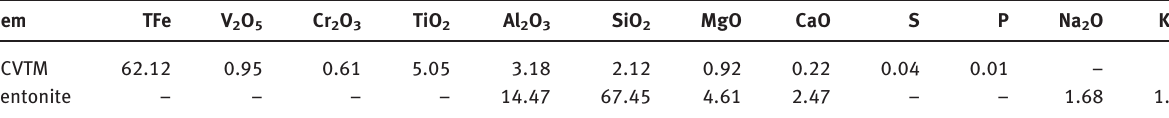
Table 1: Chemical compositions of HCVTM and bentonite (mass %).